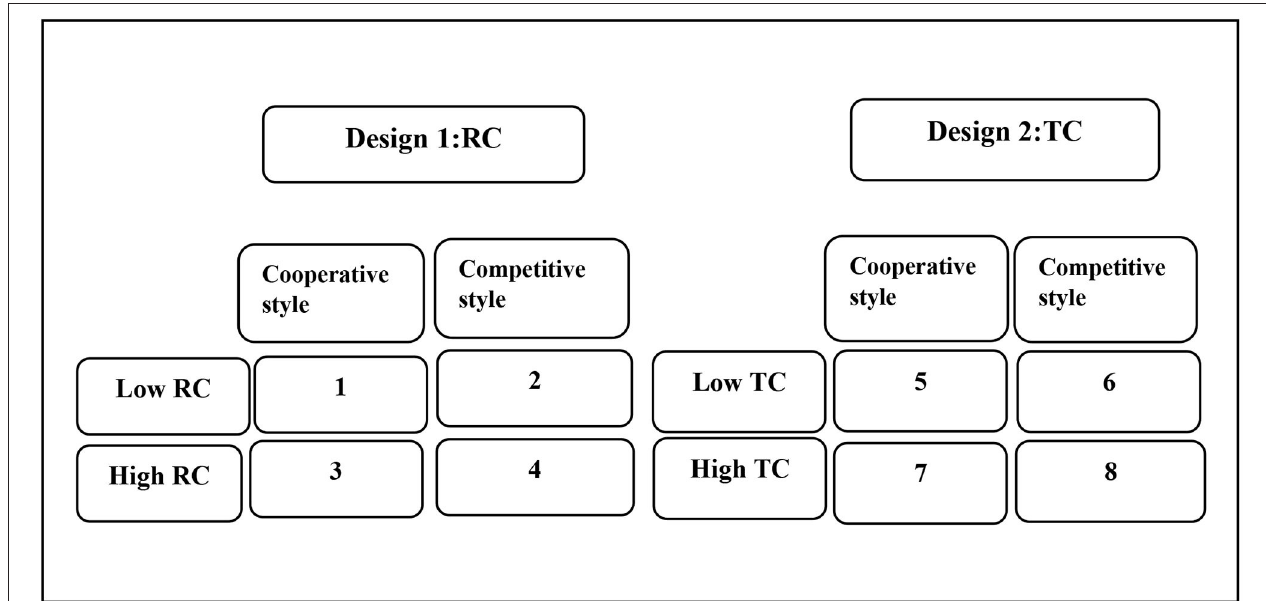
FIGURE 1 | The design of the study. RC, Relationship conflict; TC, Task conflict; 1–8: each condition of the study.